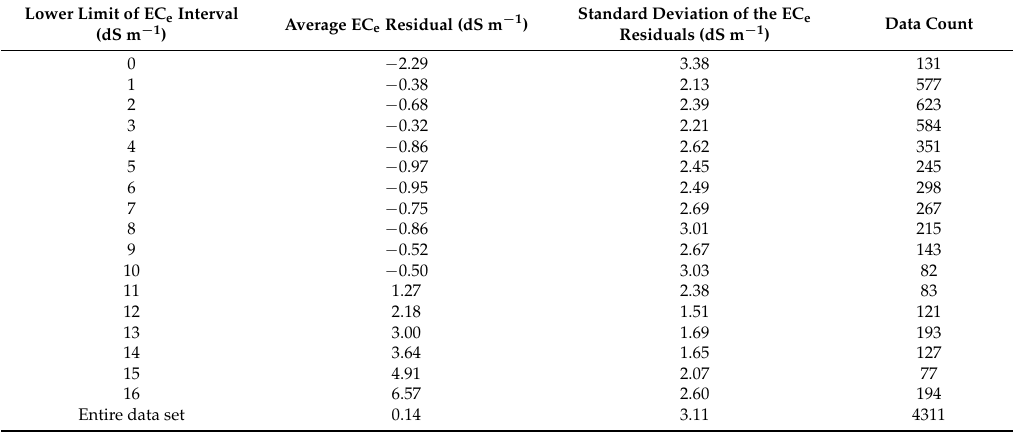
Table 5. Summary of the average residual, standard deviation of the residual, and data count for each category of predicted salinity (i.e., EC e ) from Scudiero et al. [29], indicating the uncertainty of the EC e prediction and used in defining the EC e residual